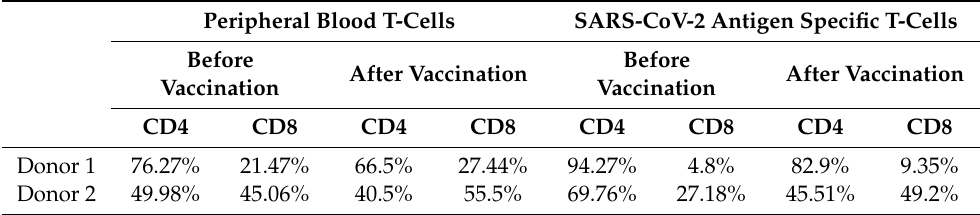
Table 4. CD4/CD8 T-cells. Percentage of CD4 and CD8 T-cell populations analyzed in peripheral blood lym- phocytes and SARS-CoV-2 antigen-specific T-cells from aphaeresis before vaccination and after